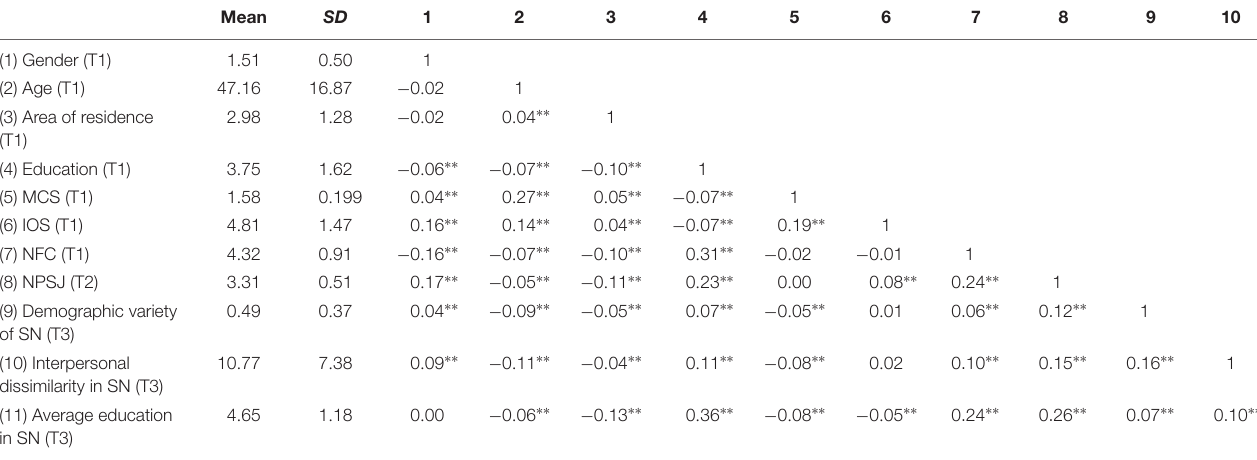
TABLE 1 | Means, standard deviations, and correlations among the model variables.